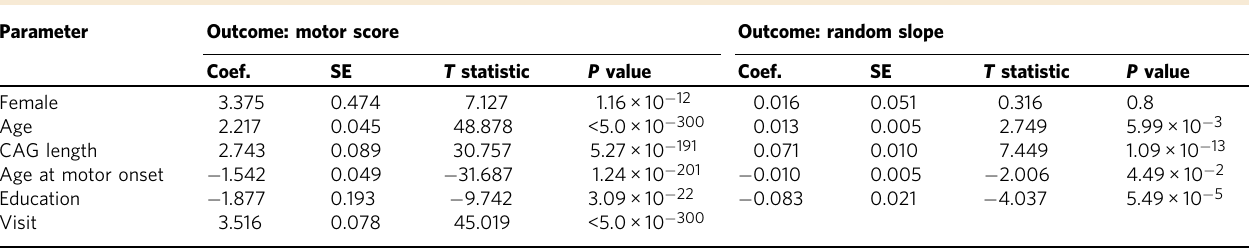
Fig. 1 EWAS of motor progression in manifest HD cases. a The spaghetti plot illustrates how the motor score depends on the visit in Enroll-HD. To arrive at a measure of motor score progression (i.e., the rate of change in the motor score), we estimated the slope using a random-effects model with a random slope and intercept term. b The Manhattan plot visualizes the EWAS results of motor progression in manifest HD cases: log (base 10)-transformed meta- analysis p value ( y -axis) versus the chromosomal location of each CpG ( x -axis). The EWAS results were calculated with the biweight midcorrelation tests 50 . Fixed-effects meta-analysis (weighted by inverse variance) was performed to combine the EWAS results across blood data ( N = 917) from Enroll- HD data 1, Enroll-HD data 2, and Registry data. All p values are two-sided and not adjusted for multiple comparisons. The blue and red horizontal lines correspond to suggestive signi fi cance ( α = 1.0 × 10 − 5 ) and genome-wide signi fi cant levels ( α = 1.0 × 10 − 7 ), respectively. Gene names are provided for CpGs (blue circles) with p < 1.0 × 10 − 6 with detailed summary statistics reported in Supplementary Data 3. Table 2 Linear mixed model regression analysis for HD motor